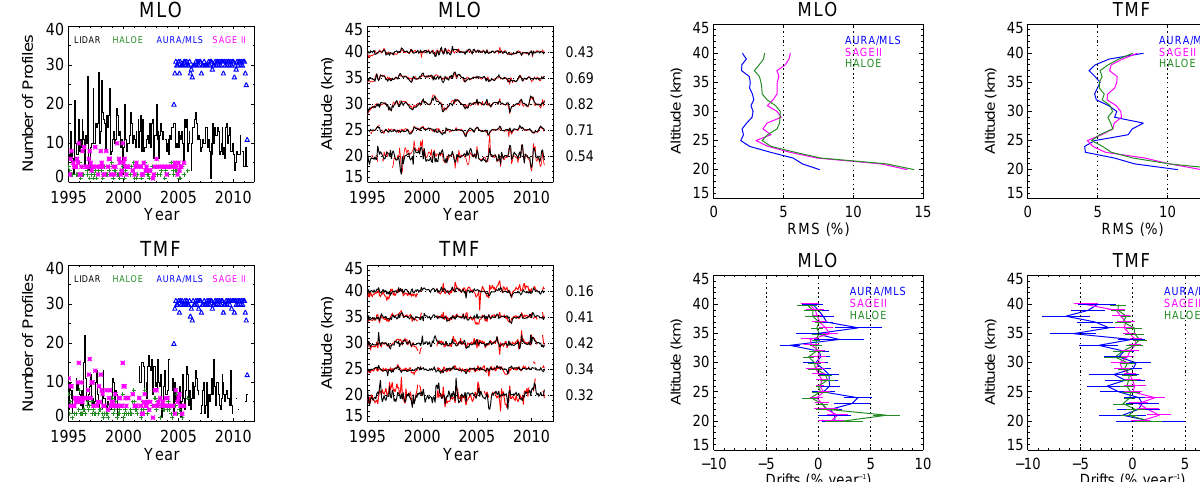
Fig. 2. RMS (%) differences between lidars and satellite measure- ments (top). Drifts (%yr − 1 ) calculated from differences between MLS, HALOE and SAGE II datasets. Dashed lines represent the 2 σ confidence